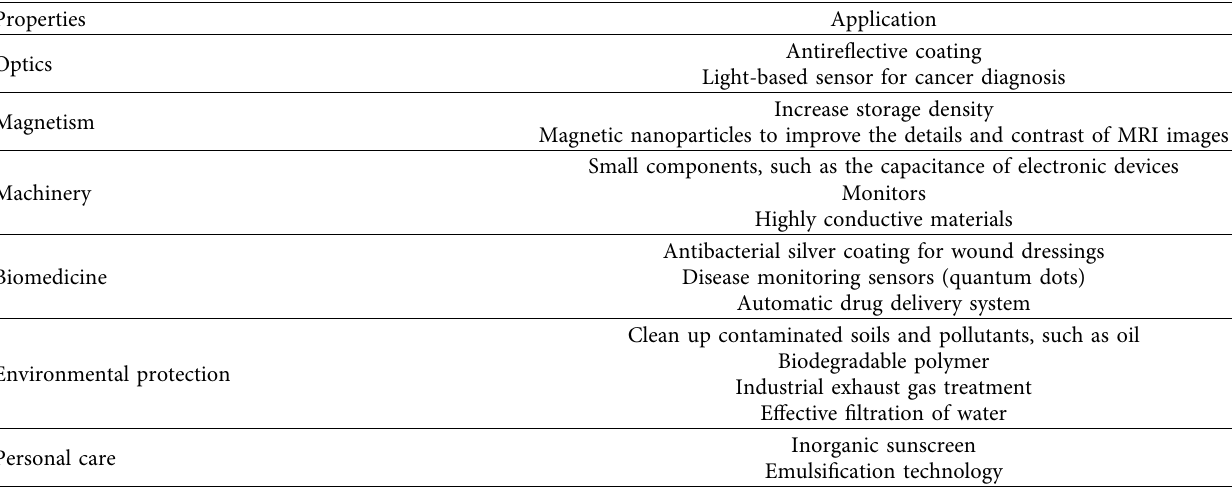
Table 4: Application areas of